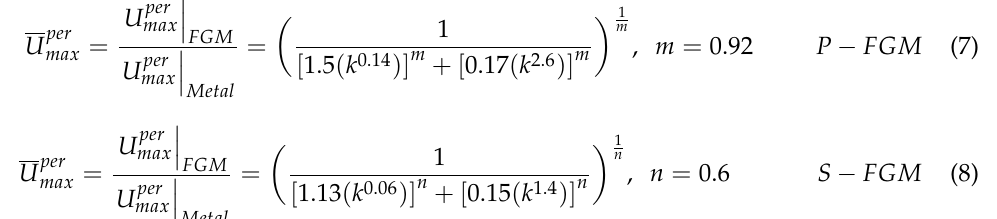
Figure 16. Prediction of the permanent indentation depth as a function of the gradient index for both S-FGM and P-FGM functions of elastoplastic Ti/TiB specimen, accounting for the gradation in all material